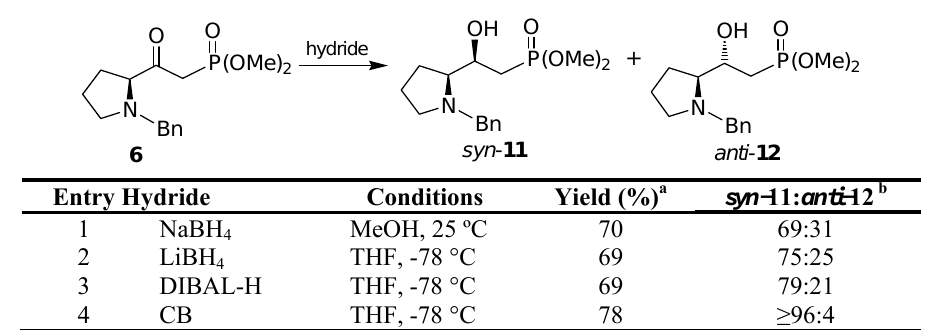
Table 1. Diastereoselective reduction of β -ketophosphonate 6 .